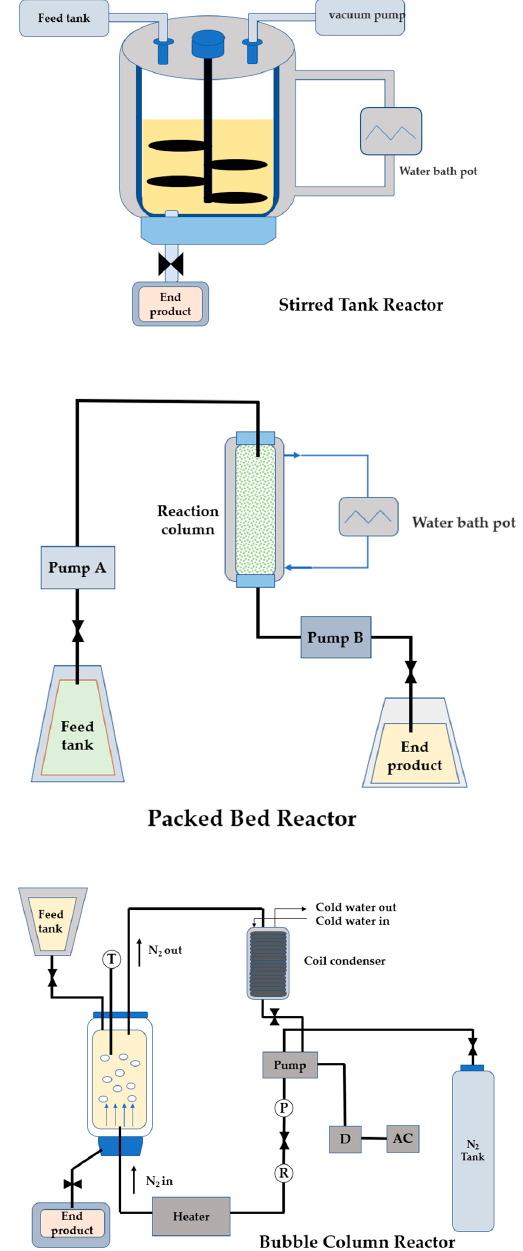
Figure 2. The Schematic diagram of several common enzyme reactors.